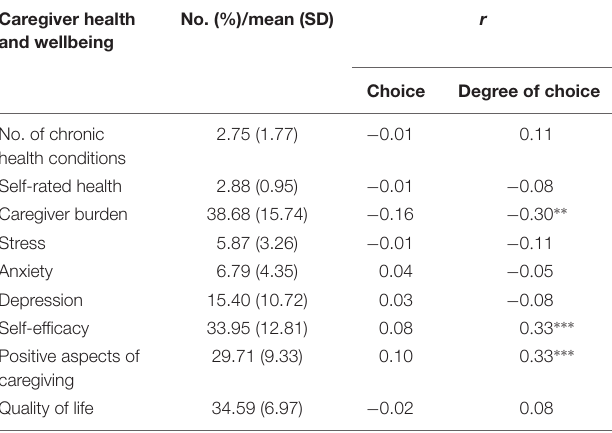
TABLE 3 | Descriptive statistics for caregiver health and wellbeing at follow-up and Pearson correlations with caregiver choice and degree of choice at baseline ( n = 151).